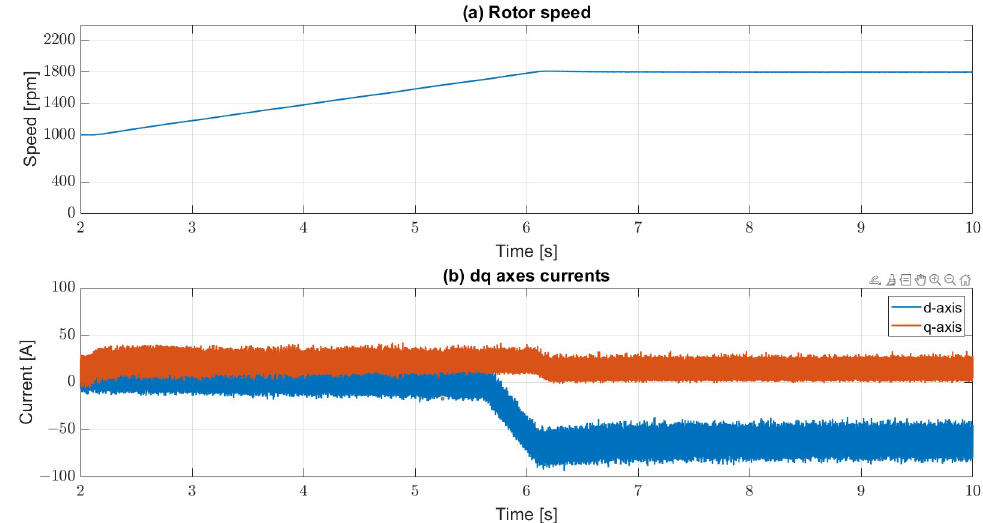
Figure 25. Field Weakening Control Simulation: ( a ) rotor speed; ( b ) dq axes currents.